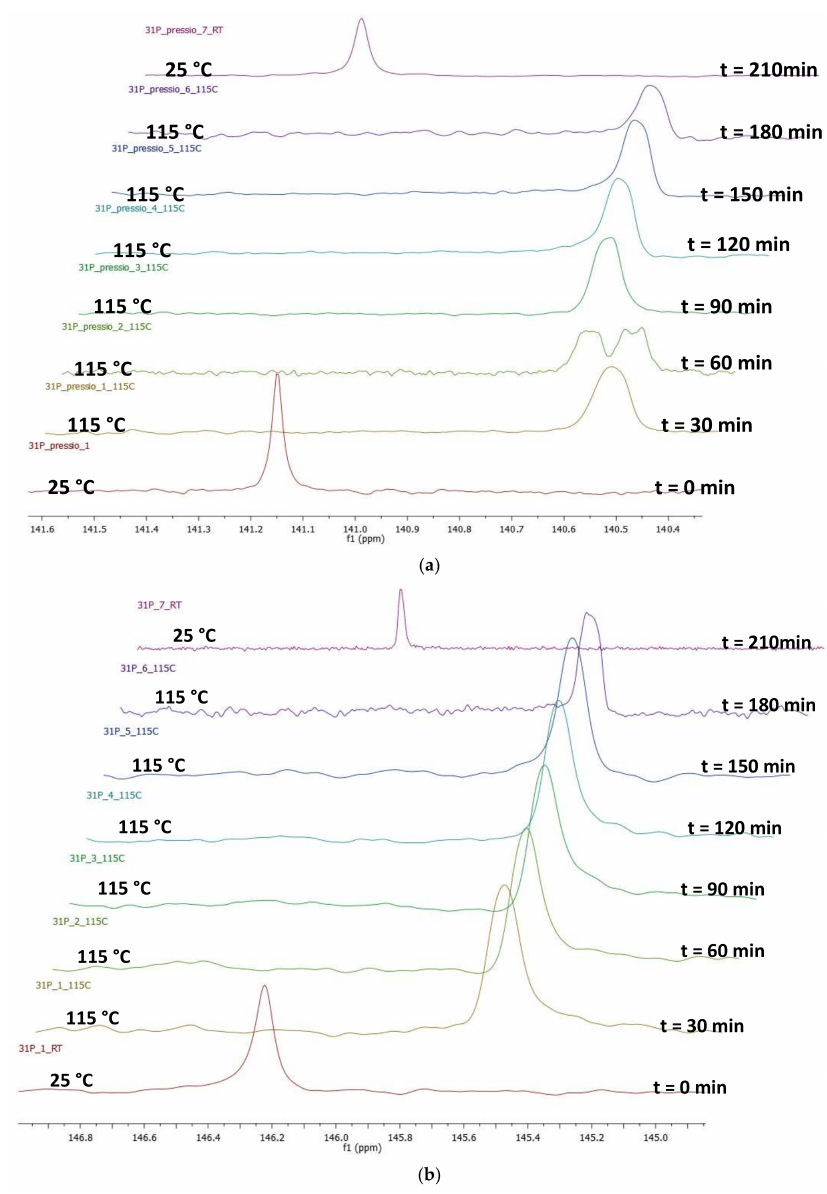
Figure A16. 31 P{ 1 H} NMR monitoring with [biphephos] 0 /[Rh] = 20: ( a ) at [ 1 ] 0 /[Rh] = 20,000; and ( b ) at [ 1 ] 0 /[Rh] =